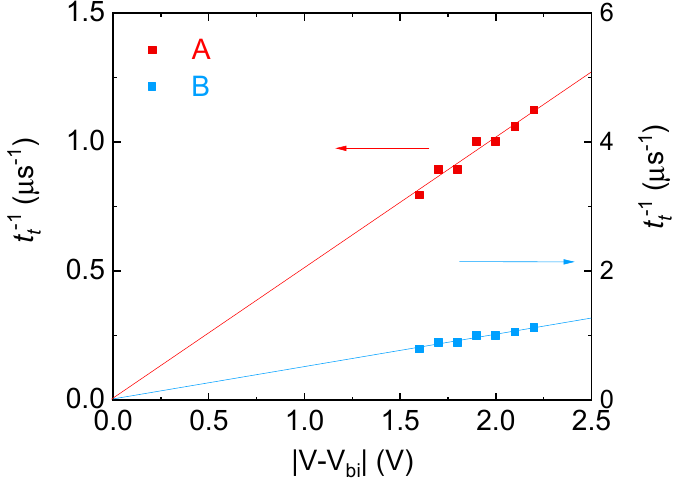
Figure 6. Effective applied voltage dependency of inverse transit times calculated from frequency regions of Figure 5.